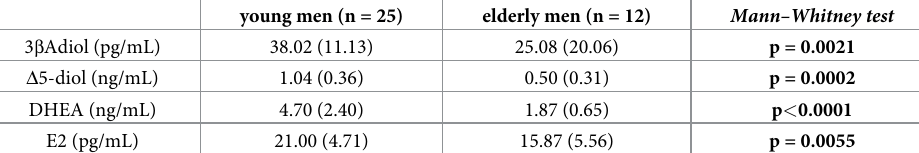
Table 5. Comparison of steroid levels between young men and elderly